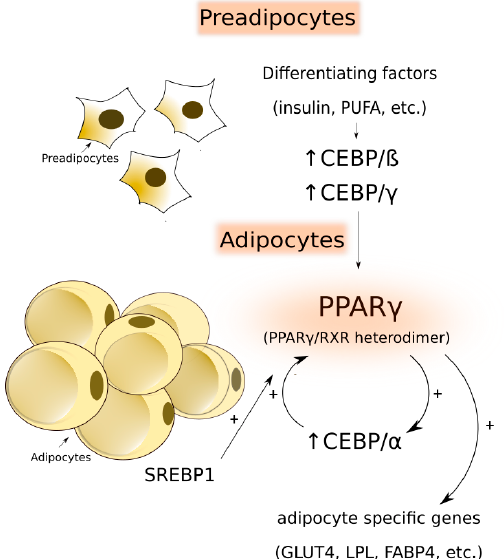
Figure 3. Transcriptional regulation of adipogenesis. ↑ = upregulation of the gene; CEBP/ß = CCAAT/enhancer-binding protein beta; C/EBP γ = CCAAT/enhancer-binding protein gamma; PPAR γ = peroxisome proliferator-activated receptor gamma; RXR = retinoid X receptor; C/EBP α = CCAAT/enhancer-binding protein alpha; SREBP = sterol regulatory element-binding proteins; FABP = fatty acid-binding proteins; GLUT4 = glucose transporter type 4, LPL = lipoprotein lipase.